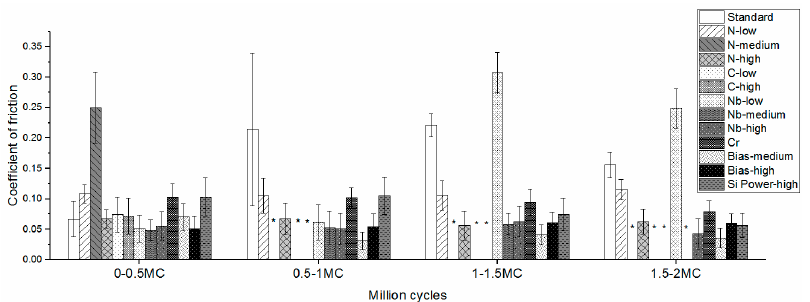
Figure 4. Coefficient of friction up to 2.0 MC for the tested coatings. During wear tests the following coatings wore through: (*) N-medium, C-high, and C-low at 0.5 MC; Nb-medium at 1.5 MC; Nb-low and Nb-high at 2.0 MC.